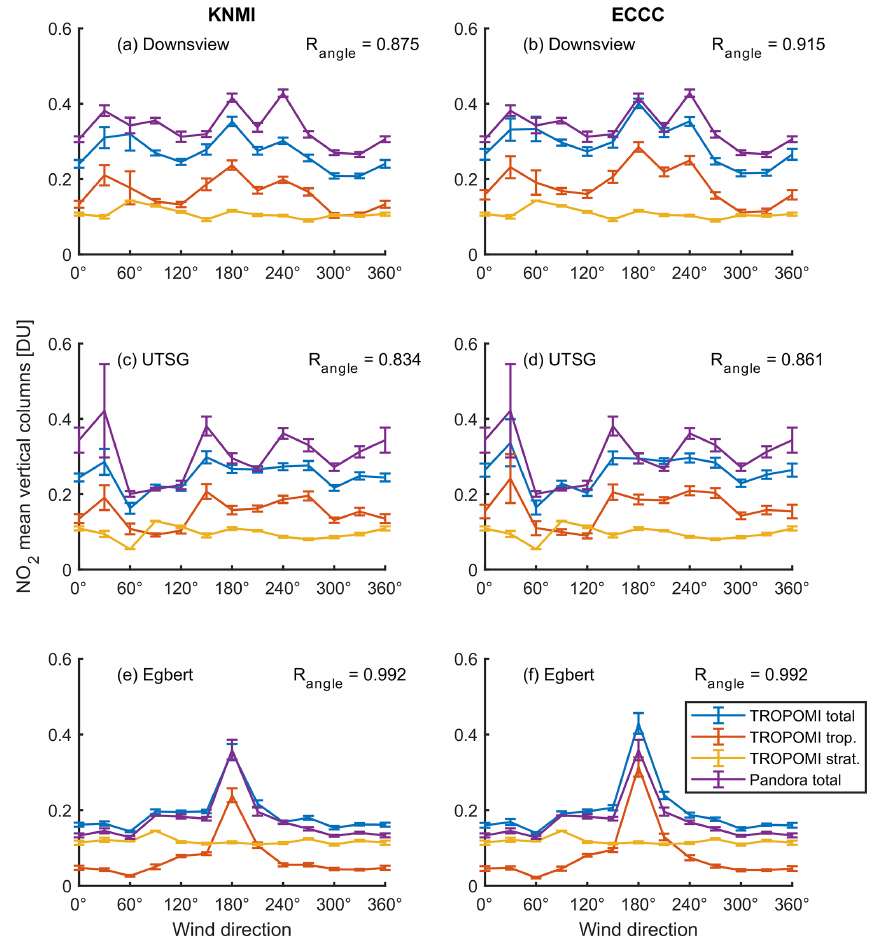
Figure 6. TROPOMI and Pandora coincident measurements from three sites, binned by wind direction. TROPOMI data in (a) , (c) , and (e) are KNMI products; (b) , (d) , and (f) are ECCC products. Blue, red, and yellow lines are TROPOMI total, tropospheric, and stratospheric columns, respectively. Purple lines are Pandora total columns. Error bars are the standard error of the mean. The correlation coefficient between TROPOMI (blue line) and Pandora total column NO 2 (purple line) is shown in each